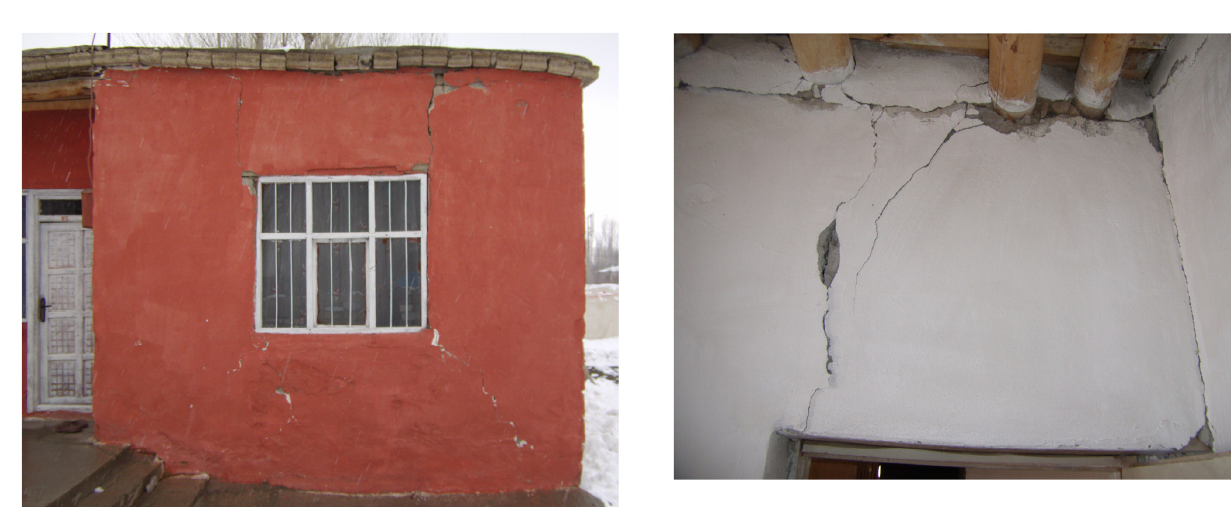
Fig. 17. Plaster spalling and the cracks developed at the spandrel part of a masonry wall above the door